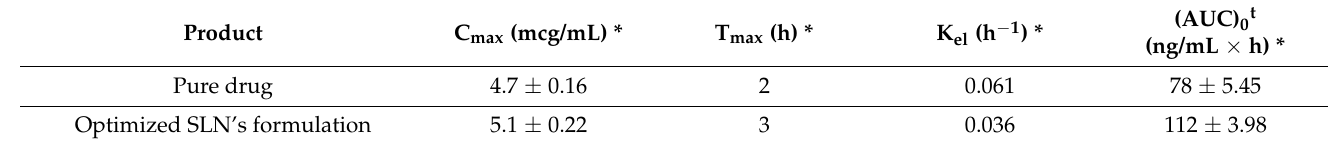
Table 4. Noted pharmacokinetic parameters for pure Saxagliptin and optimized SLN formulation.